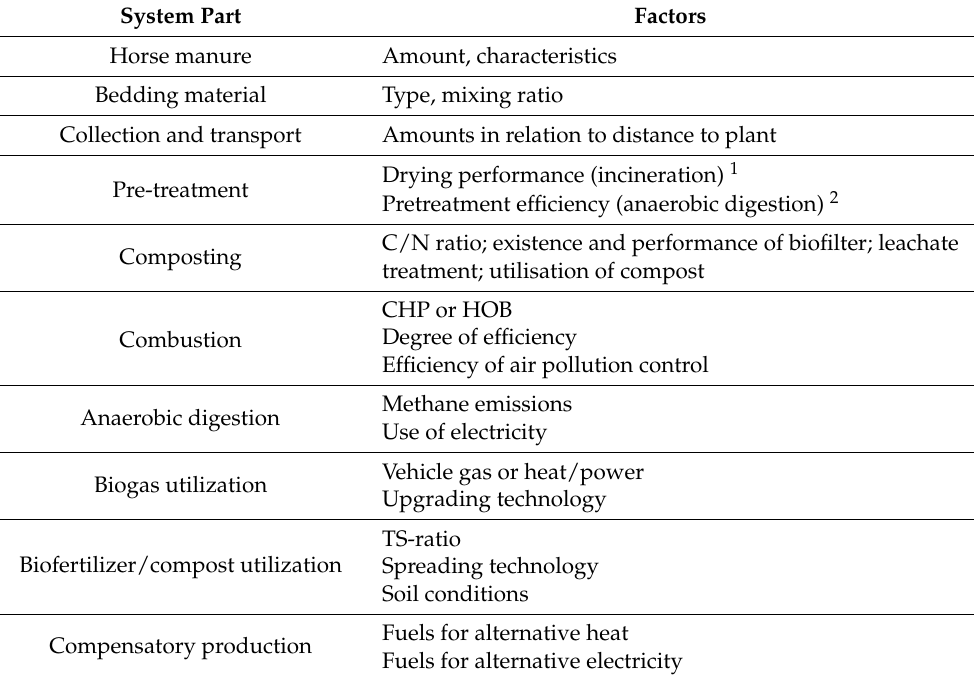
Table 5. Interesting factors to further evaluate in future Life Cycle Assessments (LCAs). CHP: combined heat and power; and HOB: heat only